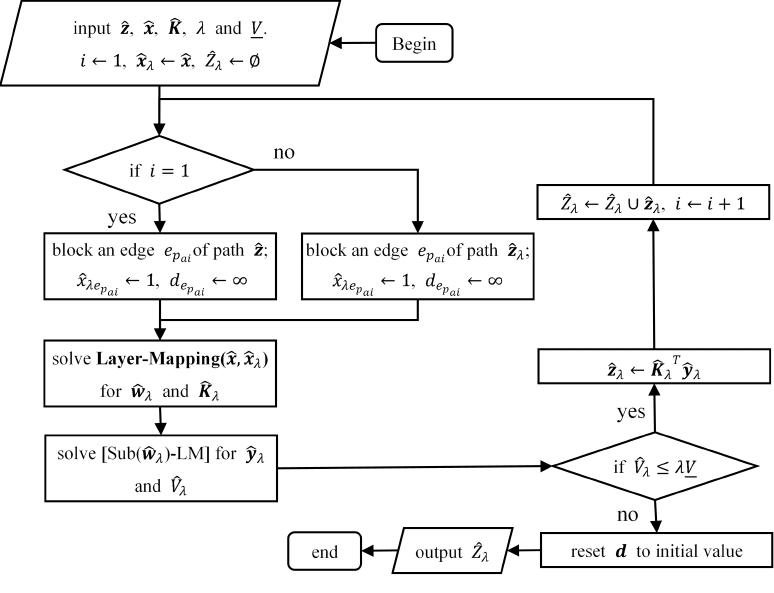
Figure 2. The process of